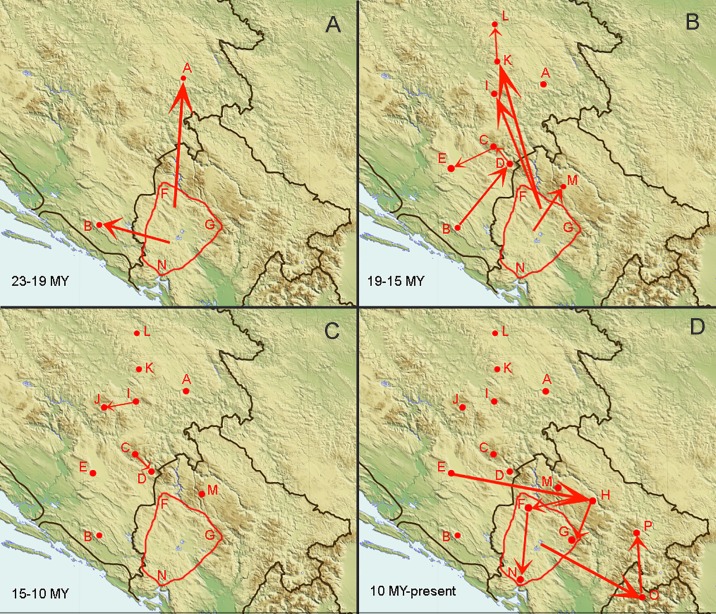
Inferred biogeographic history of Anthroherpon using the BAYAREALIKE+j model.Geographical areas used in the analyses are marked with same letters as in Fig 3. Arrows denote dispersal directions.